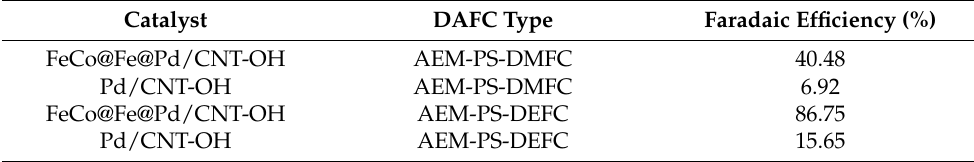
Table 4. Faradaic efficiency evaluation of the nanocatalysts, adapted from